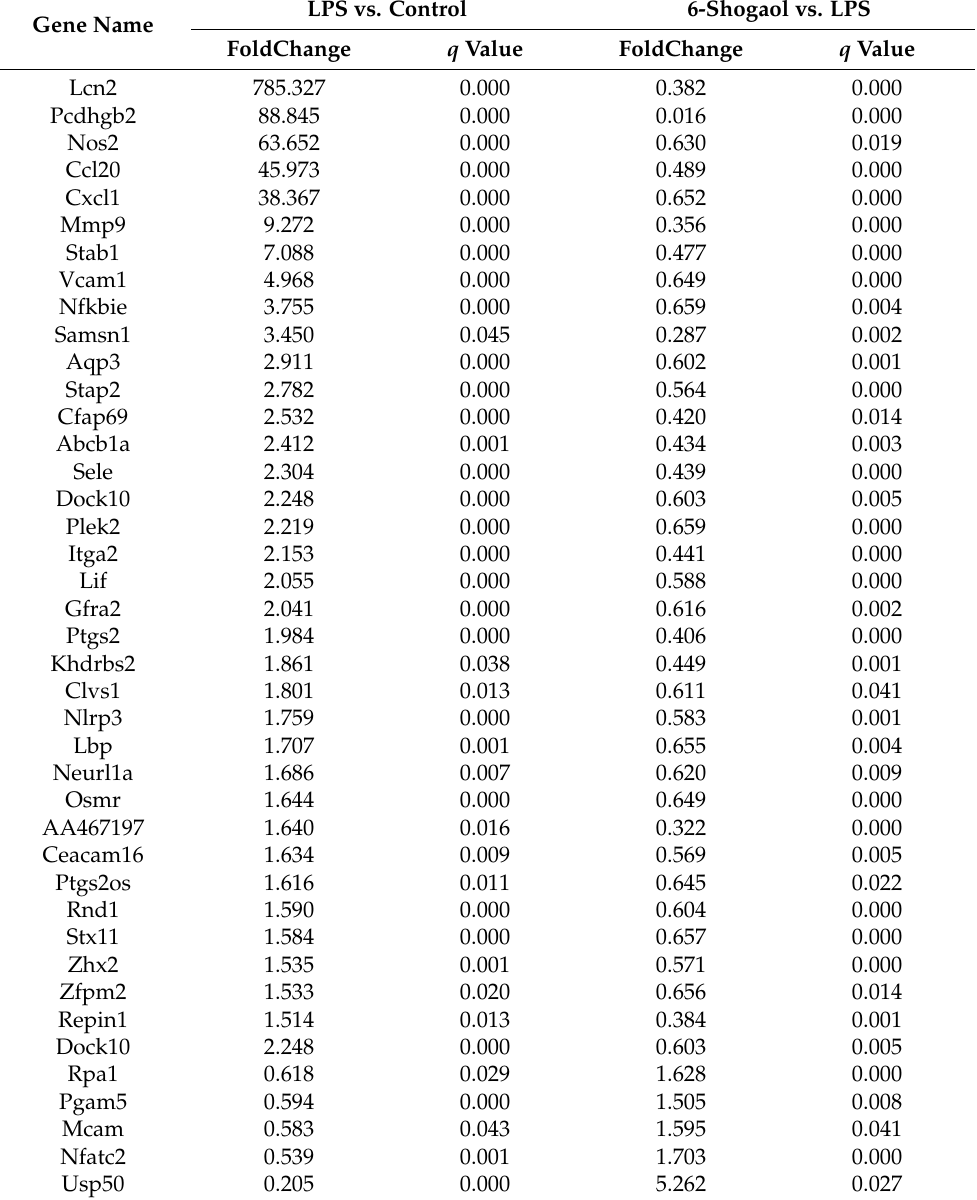
Table 2. The overlapped differentially expressed genes